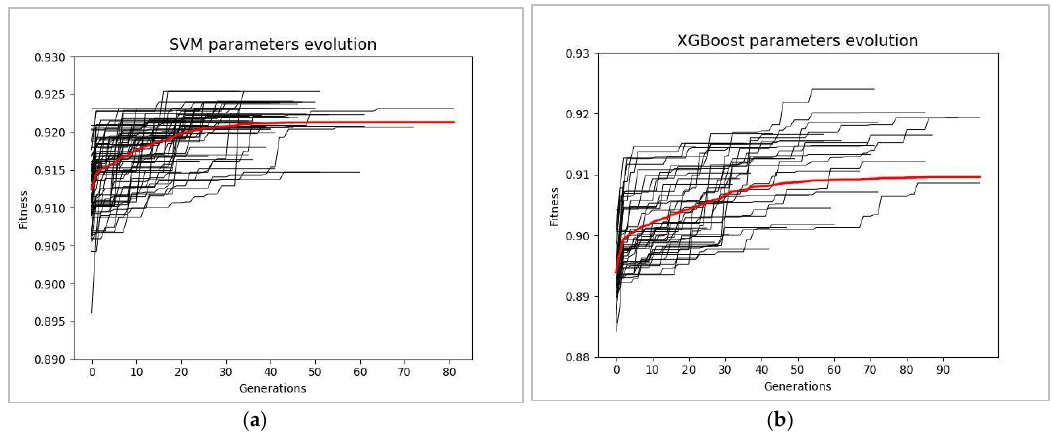
Figure 11. Fitness convergence characteristics obtained from 100 independent runs of GA employed for evolution of optimal hyperparameters of SVM ( a ) and XGBoost ( b ), respectively. The red line indicated the average (over 100 runs) of the fitness value. The sample best-evolved chromosomes containing the optimal values of hyperparameters of SVM and XGBoost are shown in Tables 9 and 10, respectively. Table 9. Best-evolved values of hyperparameters of SVM.